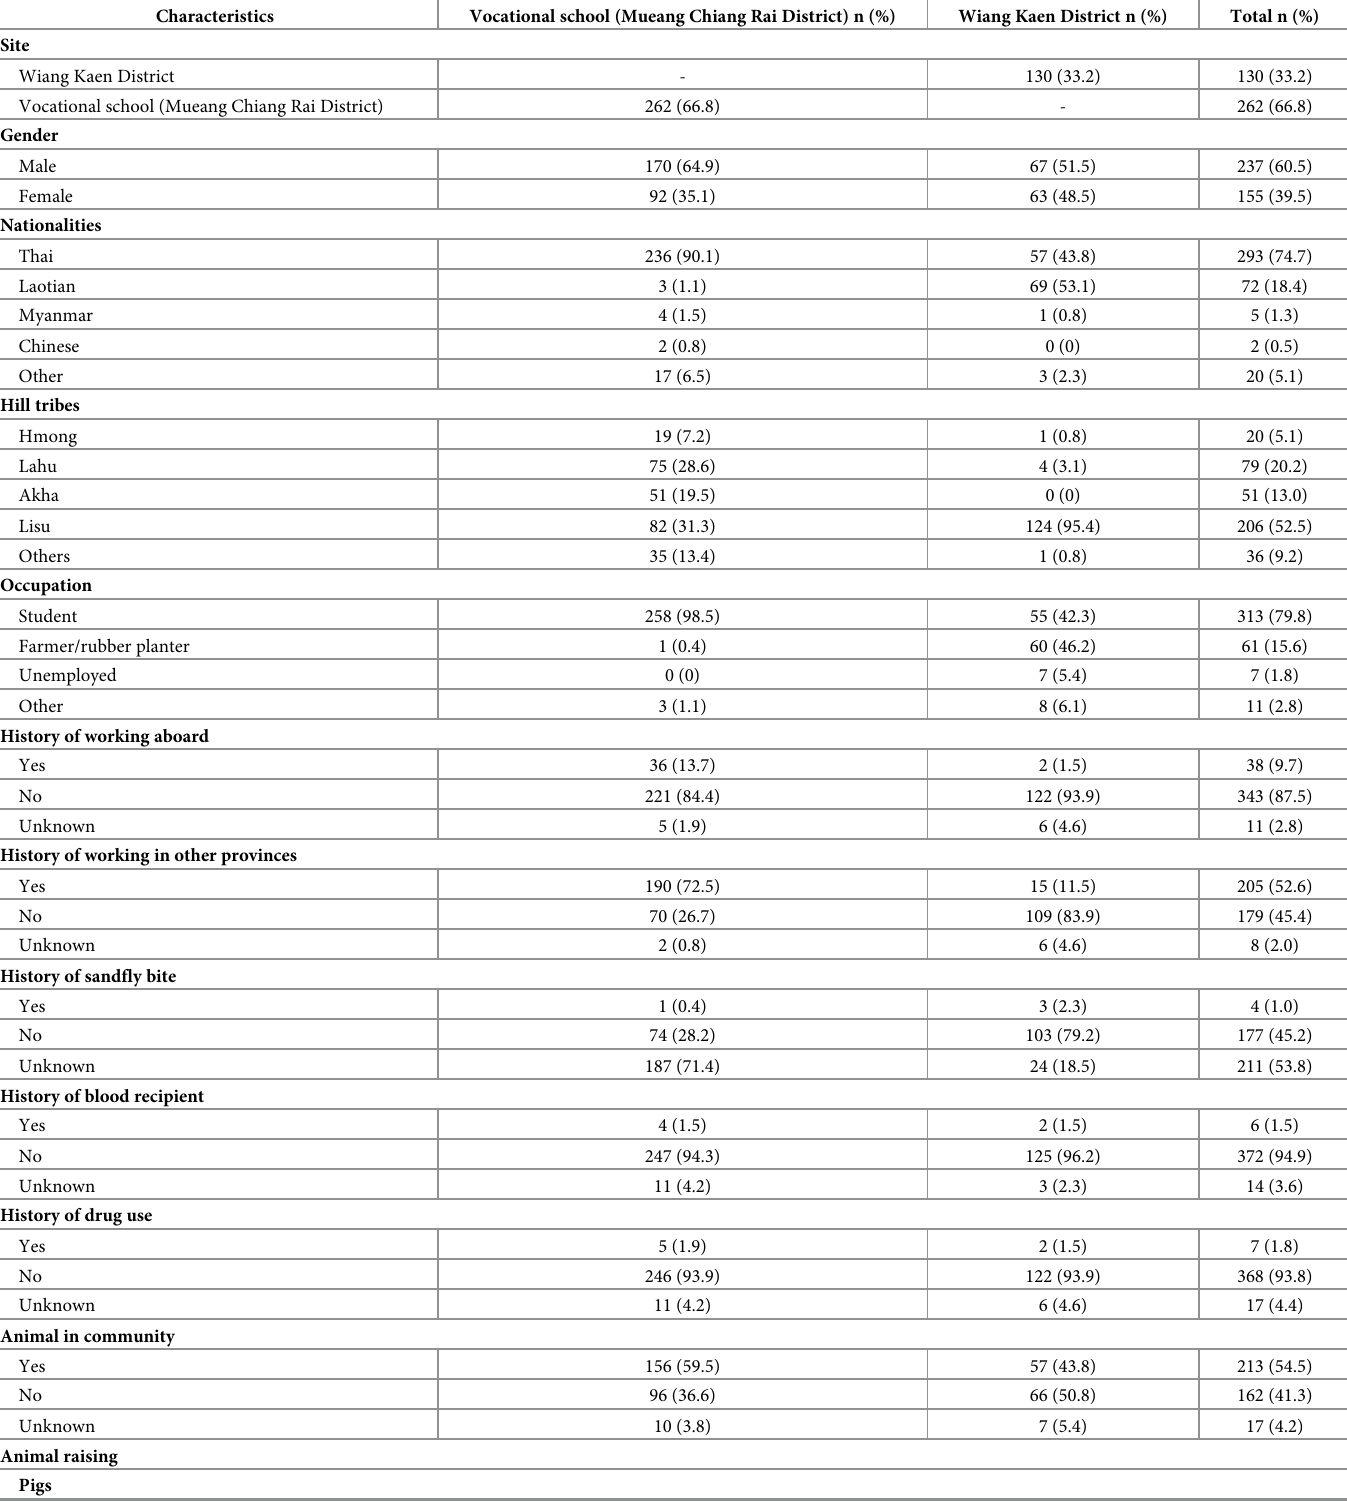
Table 1. Baseline characteristics of studied population.